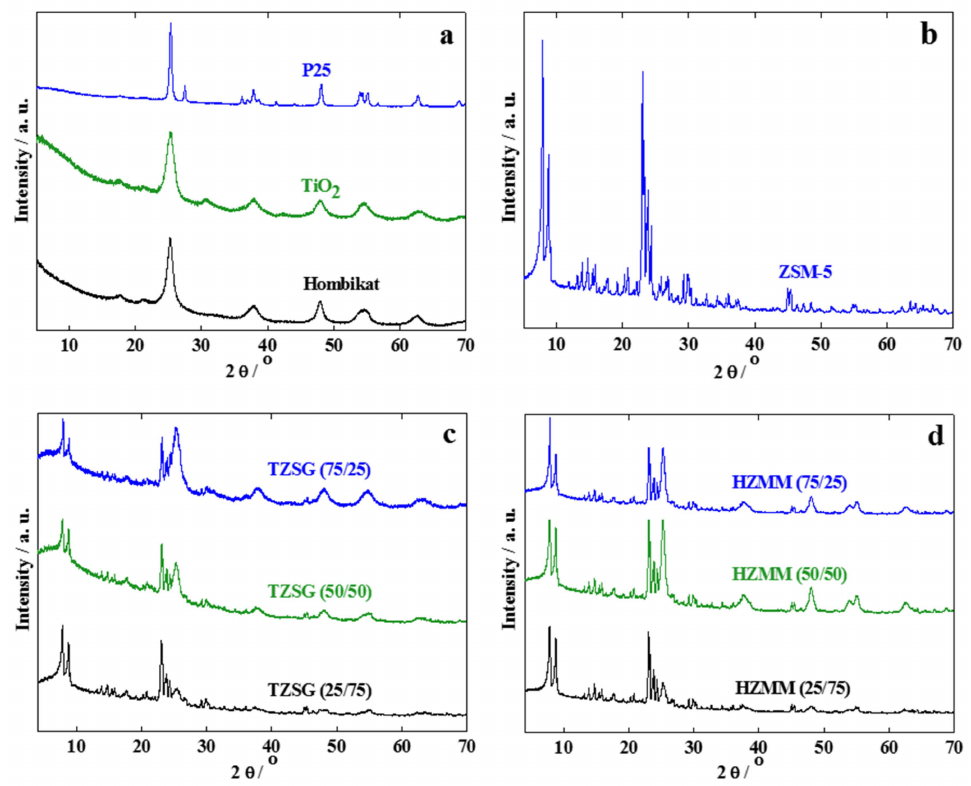
Figure 1. XRD patterns of ( a ) Hombikat, TiO 2 from sol-gel synthesis and P25; ( b ) zeolite ZSM-5; ( c ) composites from sol-gel synthesis (TZSG); and ( d ) composites from mechanical mixture